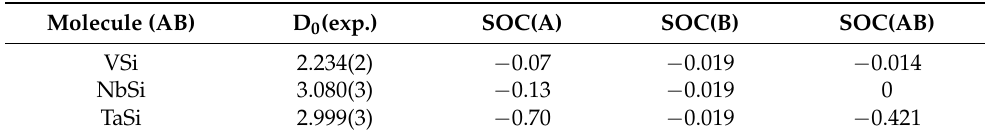
Table 3. The experimental bond dissociation energy, D 0 , and the presently used values for spin-orbit contributions to the energies where A is V, Nb, or Ta, and B is Si. All entries are in eV, and the numbers in parentheses are the experimental uncertainties in the last digit. Molecule